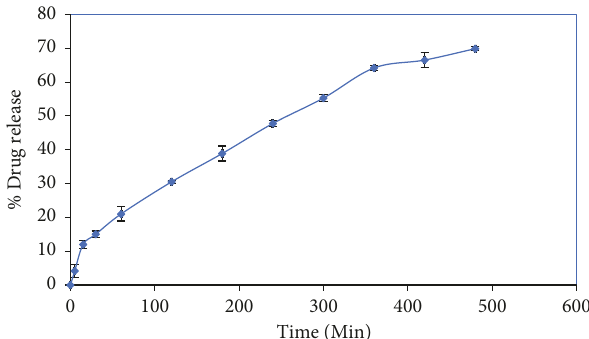
Figure 9: In vitro drug release of the microneedle.